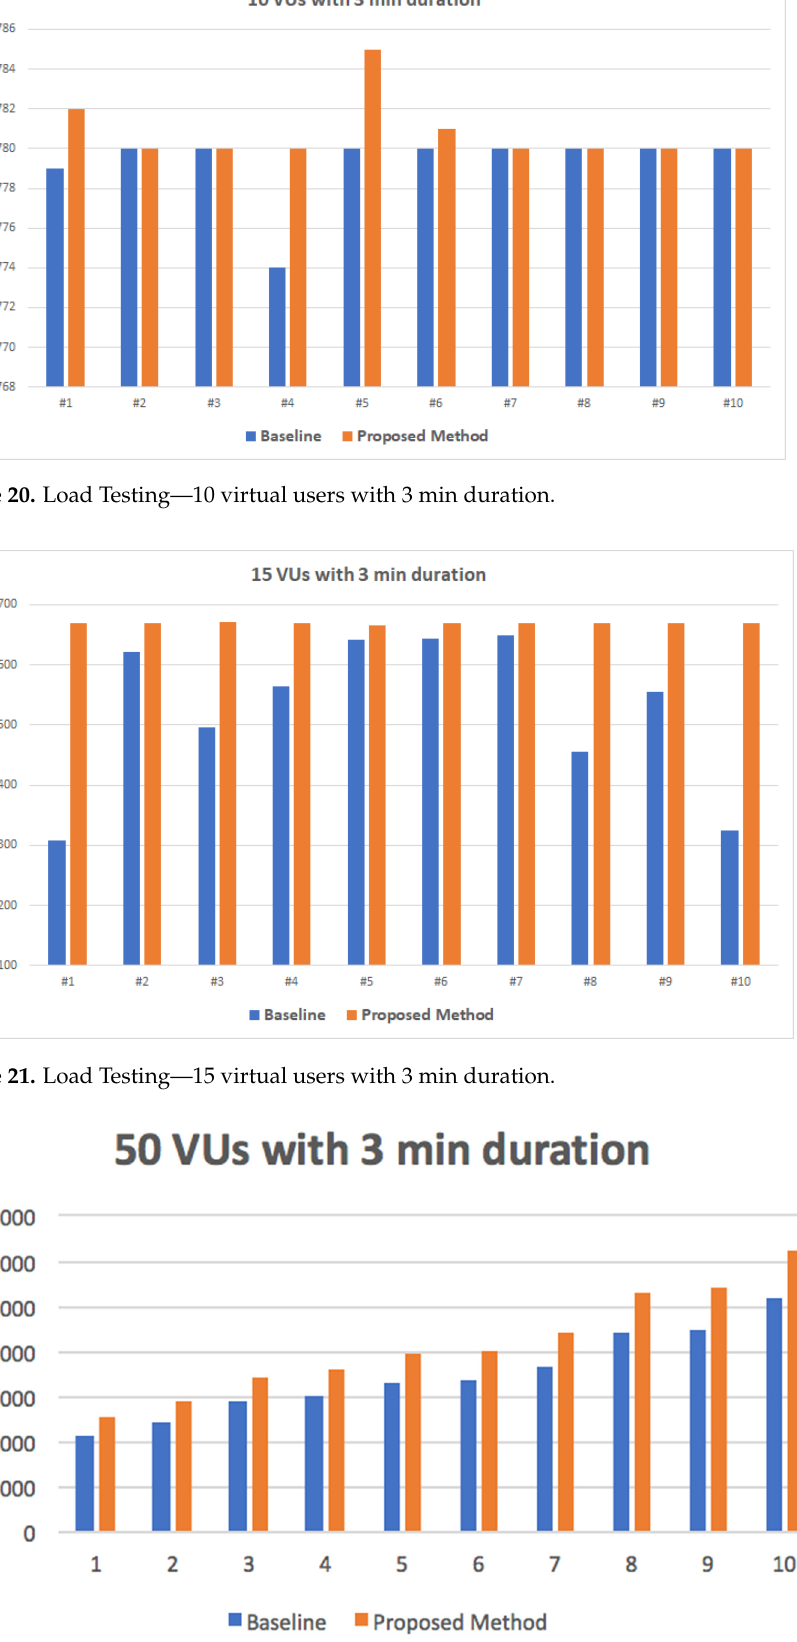
Figure 22. Load Testing—50 virtual users with 3 min duration.